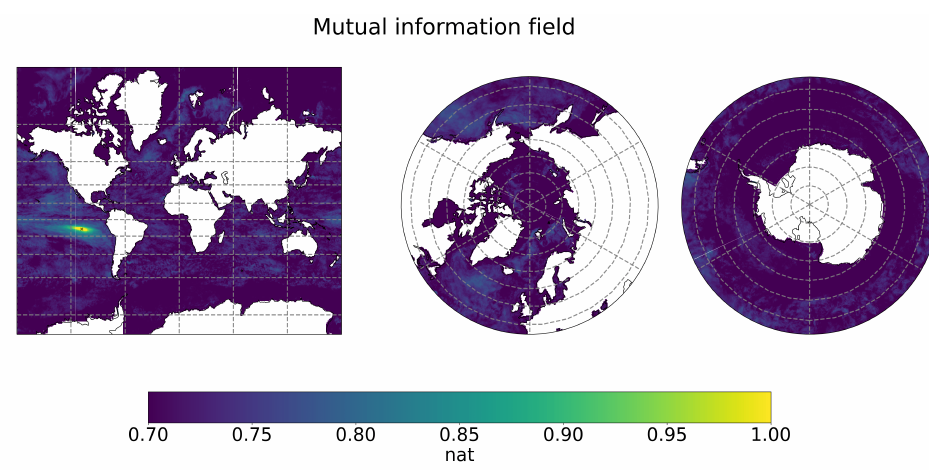
Figure 16. Mutual information field for the temperature at 9 m from the training